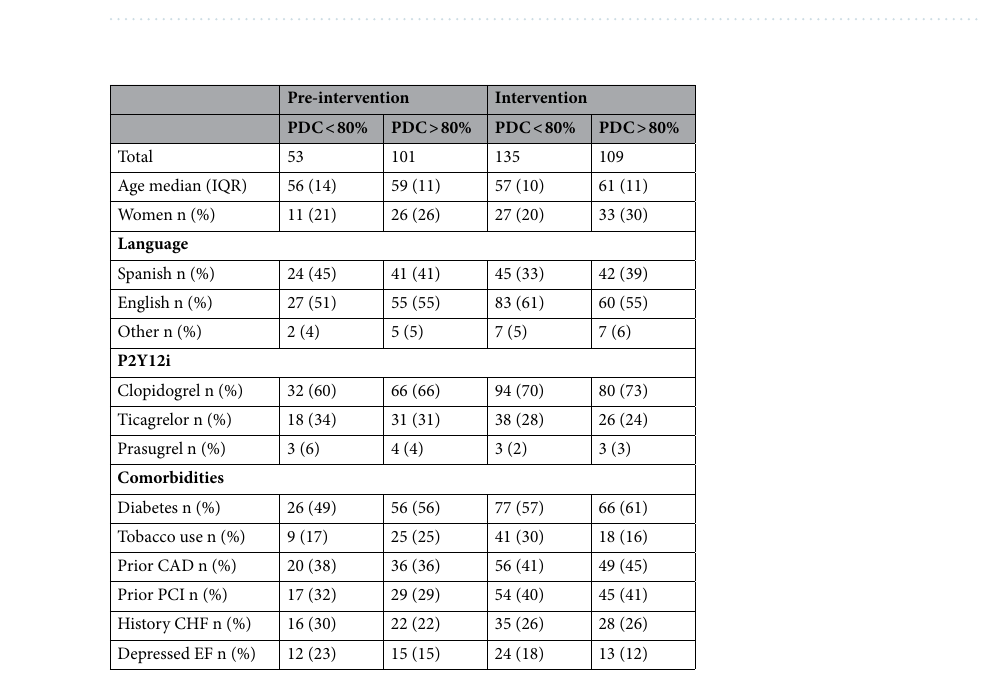
Table 3. PDC rates.